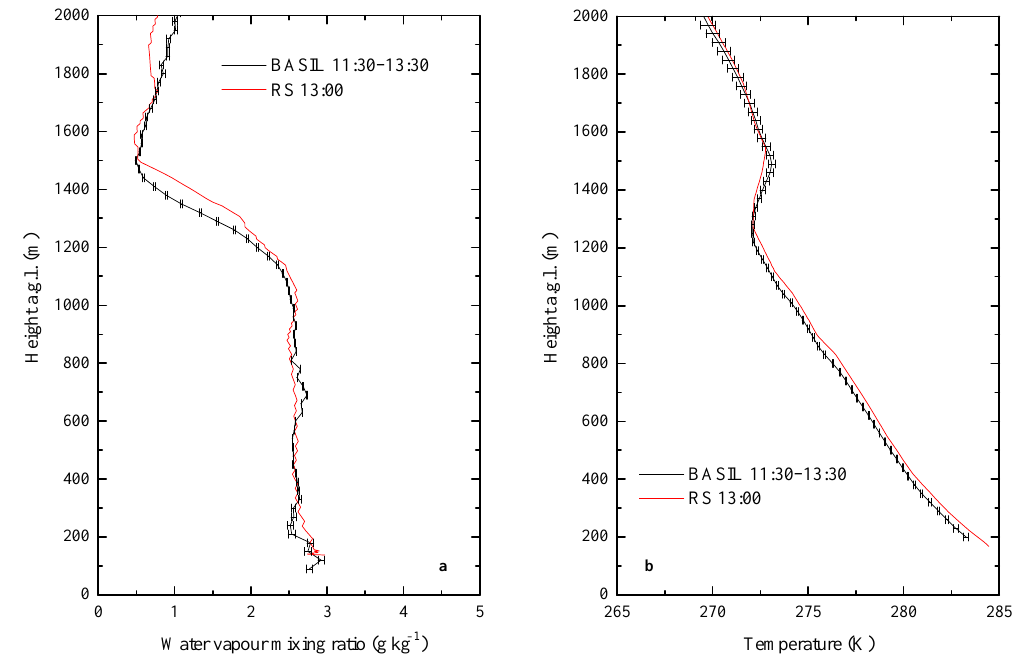
Figure 6. Mean water vapour mixing ratio (a) and temperature (b) profiles measured by BASIL on 20 April 2013 between 11:30 and 13:30UTC, together with the corresponding profiles as measured by a radiosonde launched at 13:00UTC from the nearby site of Hambach. Noise error bars are also